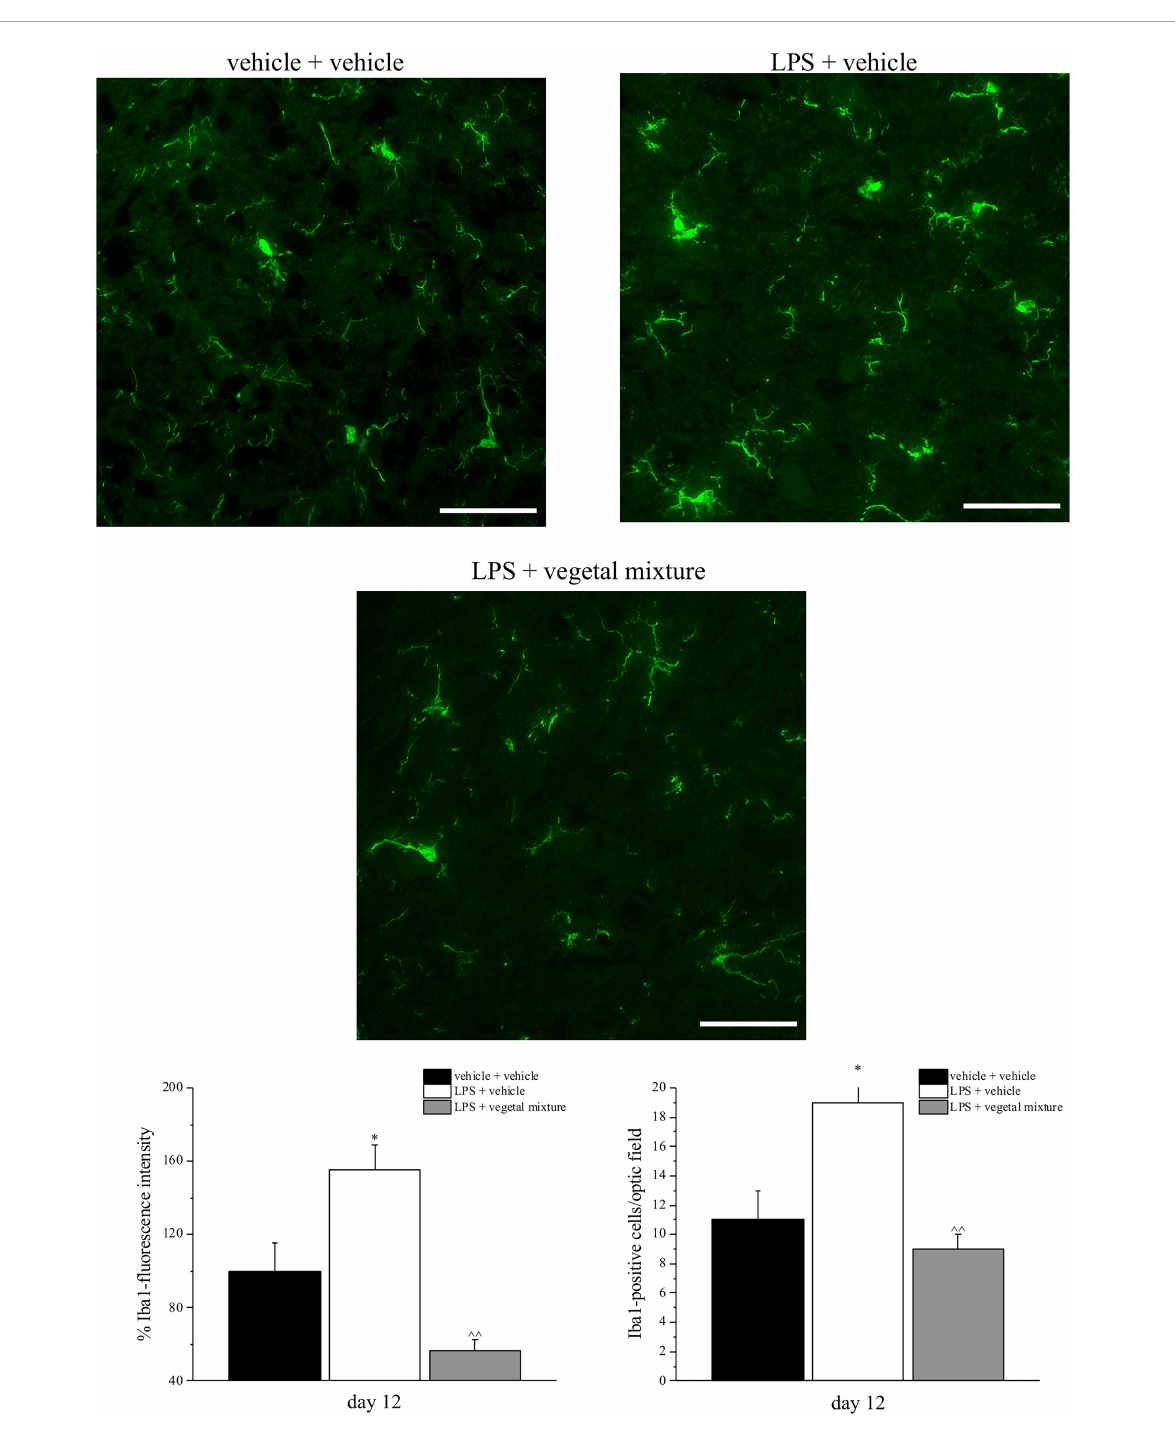
FIGURE7 Effect of a vegetal mixture on LPS-induced microglial activation. LPS (1 mg kg - 1 ) was intraperitoneally injected on days 1, 3, 5, and 8. The vegetal mixture was composed of Zingiber officinale (150 mg kg - 1 ), Echinacea purpurea (20 mg kg - 1 ), and Centella asiatica (200 mg kg - 1 ), suspended in 1% carboxymethylcellulose sodium salt (CMC) and orally administered daily starting from day 1 till the end of the experiment. Control animals were treated with vehicles. At the end of the behavioral experiments and 24 h after the last administration of the vegetal mixture, animals were sacrificed and the lumbar spinal cord was collected. The number of Iba1-positive cells was measured in the dorsal horn of the L4–L5 spinal cord. Transverse sections of the spinal cord were imaged with a × 40 objective lens (scale bar = 50 µ m). Histograms show the quantitative analysis of Iba1 fluorescence intensity and the number of Iba1-positive cells/optic fields. Data are expressed as the mean ± SEM of values from eight mice analyzed in two different experimental sets. ∗ p < 0.05 vs. vehicle + vehicle; ∧∧ p < 0.01 vs. LPS +